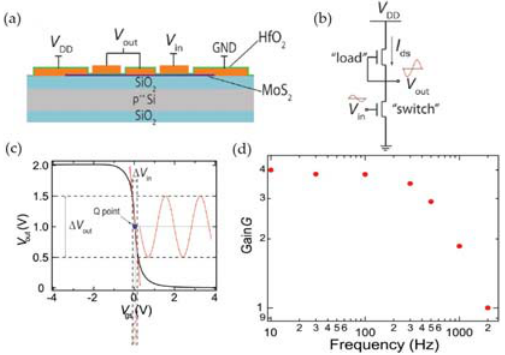
Figure 18. ( a ) Vertical cross section of the MoS 2 amplifier device. ( b ) Schematic drawing of integrated amplifier in common ‐ source configuration. ( c ) Transfer characteristic of the integrated amplifier realized with two transistors on the same MoS 2 flake. ( d ) Voltage gain dependence on frequency of the small input signal. Reproduced with permission from [102], American Institute of Physics, 2012.